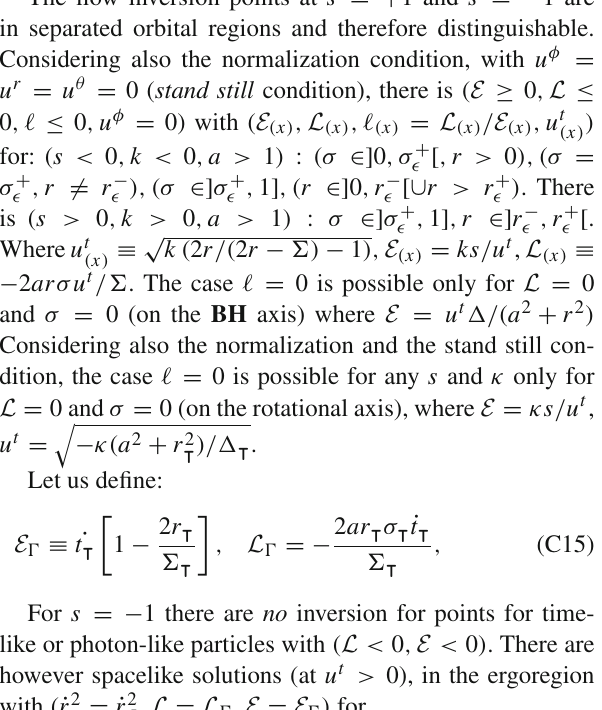
Fig. 29 Analysis of inversion plane σ (cid:2) with fluid specific angular momentum (cid:6) − , including co-rotating motion (cid:6) − > 0 and counter- rotating fluids with (cid:6) = (cid:6) − < 0 for spin a ∈] M , a 2 [ and orbital range , r + [−] r − , r + [ . Left panel: momentum (cid:6) − for the definition of (cid:6) in ] r − δ δ 0 0 on the geodesic radii are shown as function of the NS spin-mass ratios. Reference value (cid:6) = (cid:6) − γ = a is shown, function (cid:6) β of Eqs. (C10) on